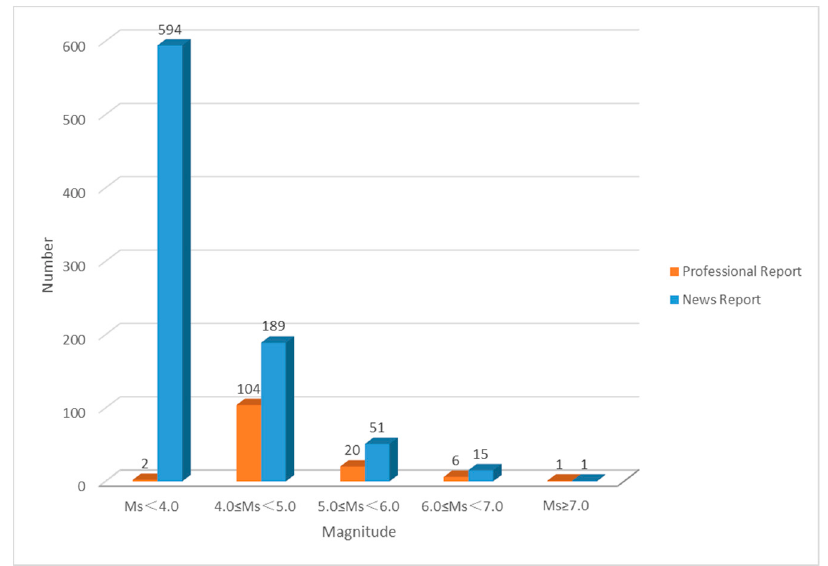
Figure 2. Number of earthquake events, by magnitude, from news reports and professional reports from 1 January 2015, to 31 November 2017. from 1 January 2015, to 31 November